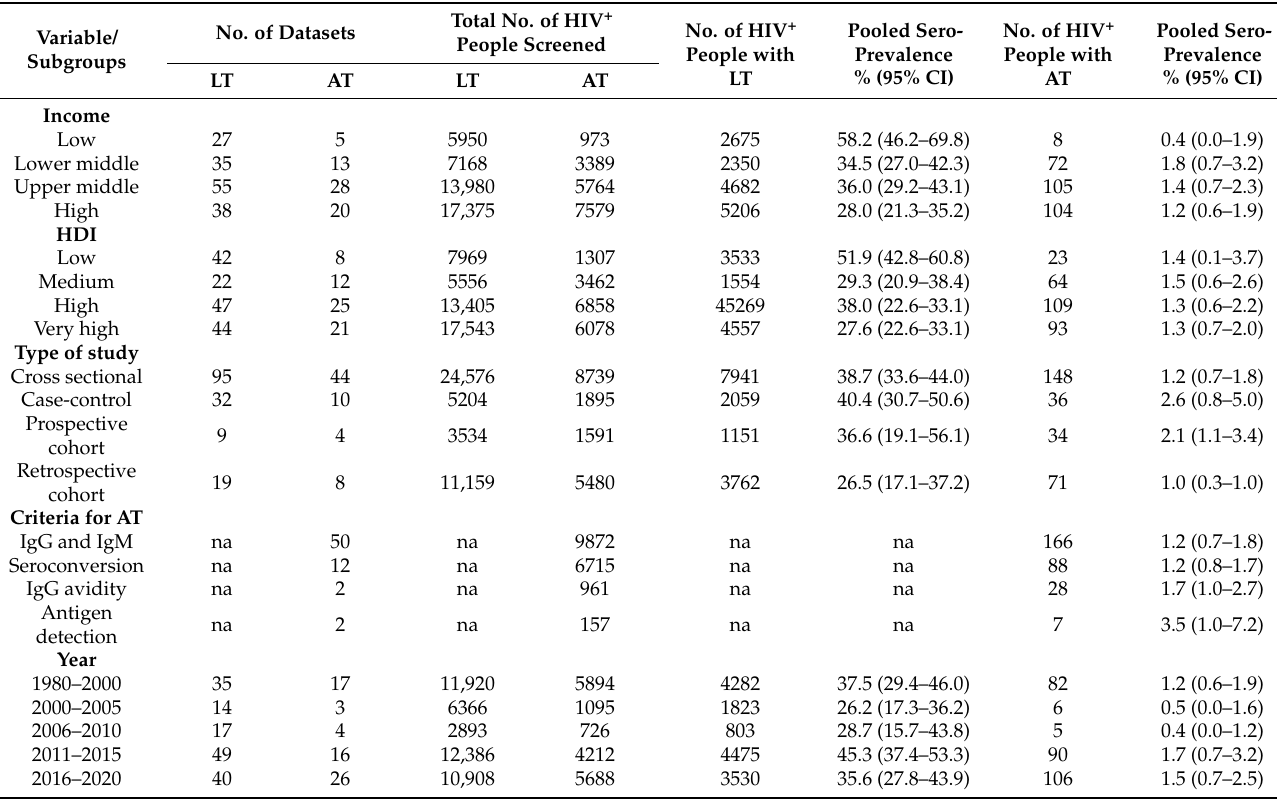
Table 2. Seroprevalence estimates for latent or acute T. gondii infections (LT and AT, respectively) in HIV + people according to a priori defined